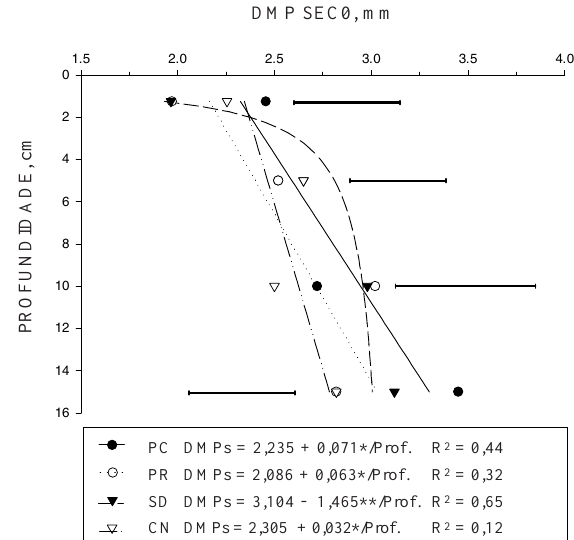
Figura 4. Estabilidade de agregados indicada pelo diâmetro médio ponderado (DMP) obtido por peneiramento úmido sob diferentes sistemas de manejo, em diferentes profundidades. Os pontos representam as médias dos tratamentos (n = 3). As barras horizontais indicam diferenças mínimas significativas entre tratamentos em uma mesma profundidade calculadas pelo teste de Duncan a 5 %. * e **: significativos a 10 e 1 %.